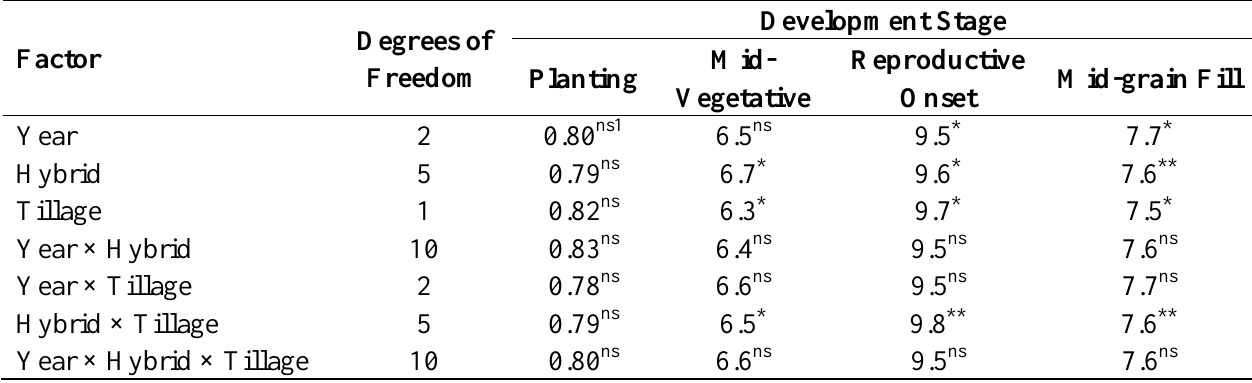
Table 4. Mean values of Chlorophyll Index (CI) observations over six corn hybrids grown in two tillage systems for the period from 2002 to 2004 for four development periods and the ANOVA for the comparison of the treatments and